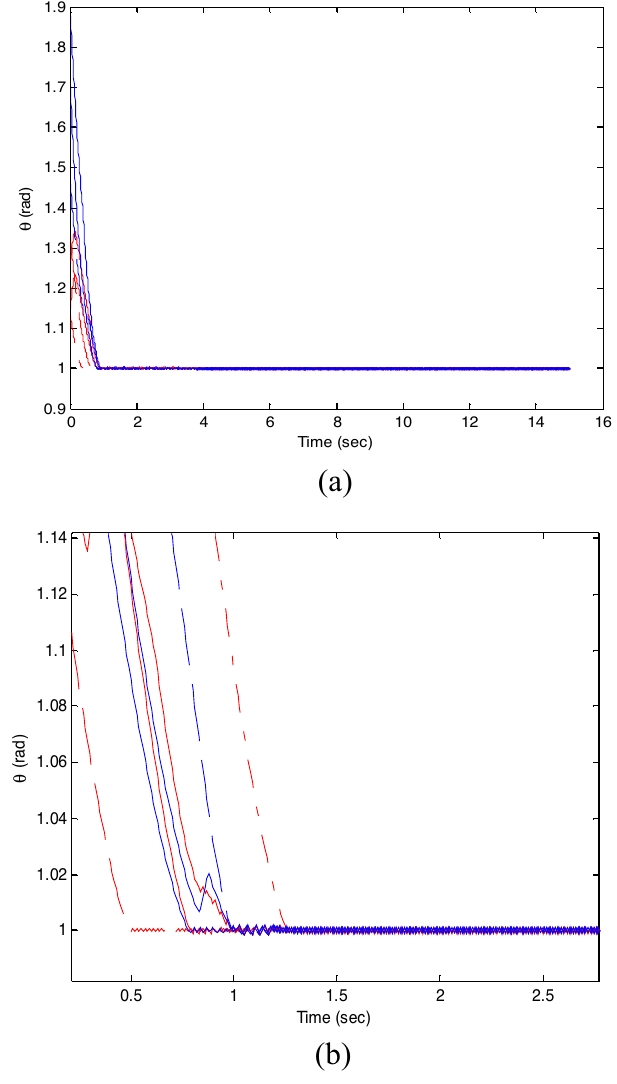
Figure 4. Consensus control on heading angle of seven agents ( b ) local magnification of figure ( a